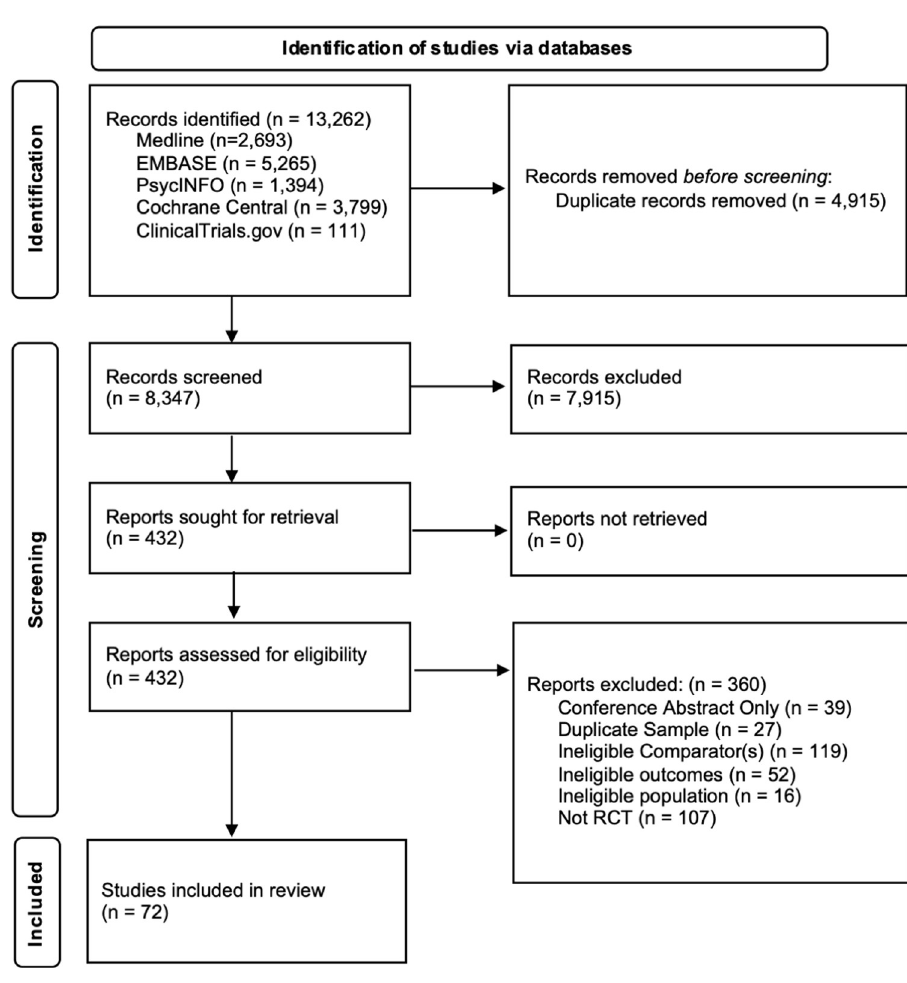
Fig 1. PRISMA flowchart of study selection